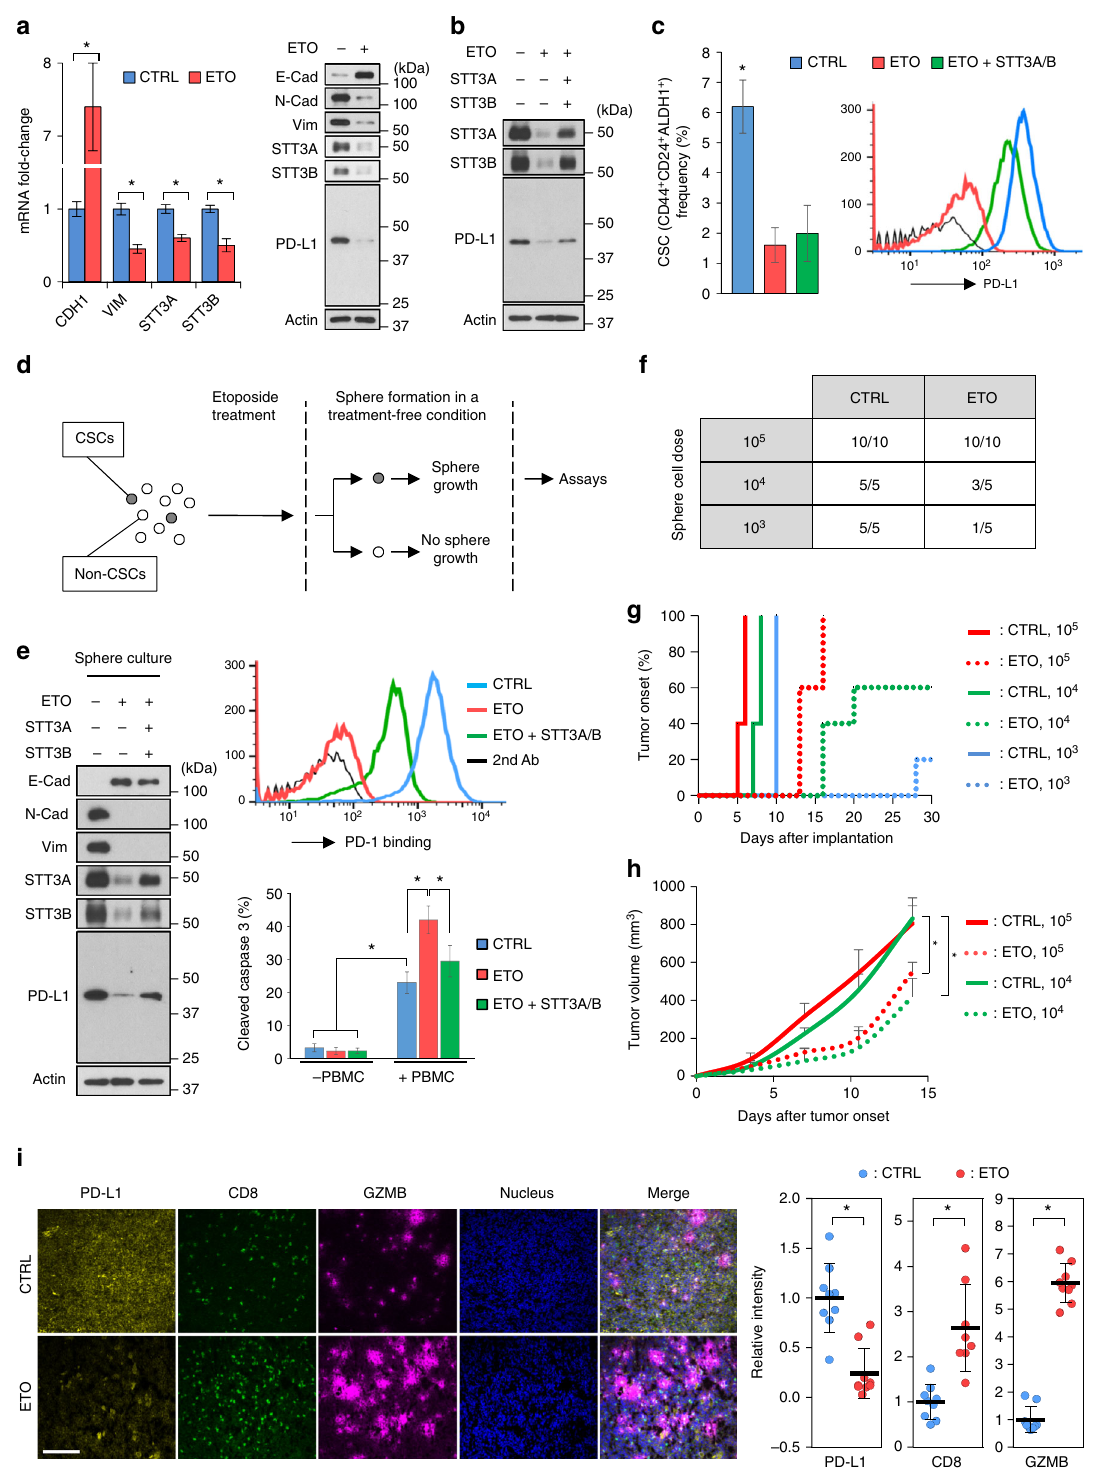
from Calbiochem: carboplatin, pentostatin, and daunorubicin. The following reagents were purchased from Santa Cruz: ICRF-187, ICRF-193, and teniposide. The following reagents were purchased from MBL International Corporation: Z- VAD-FMK. Sphere assay . Cells were dissociated with trypsin, washed, and cell viability was analyzed by trypan blue exclusion. Single-cell suspensions were plated (10,000 viable cells/well) in 6-well ultra-low attachment plates (Corning) in de fi ned serum-free medium composed of DMEM/F-12, B27 supplement (Invitrogen), 20ngml −